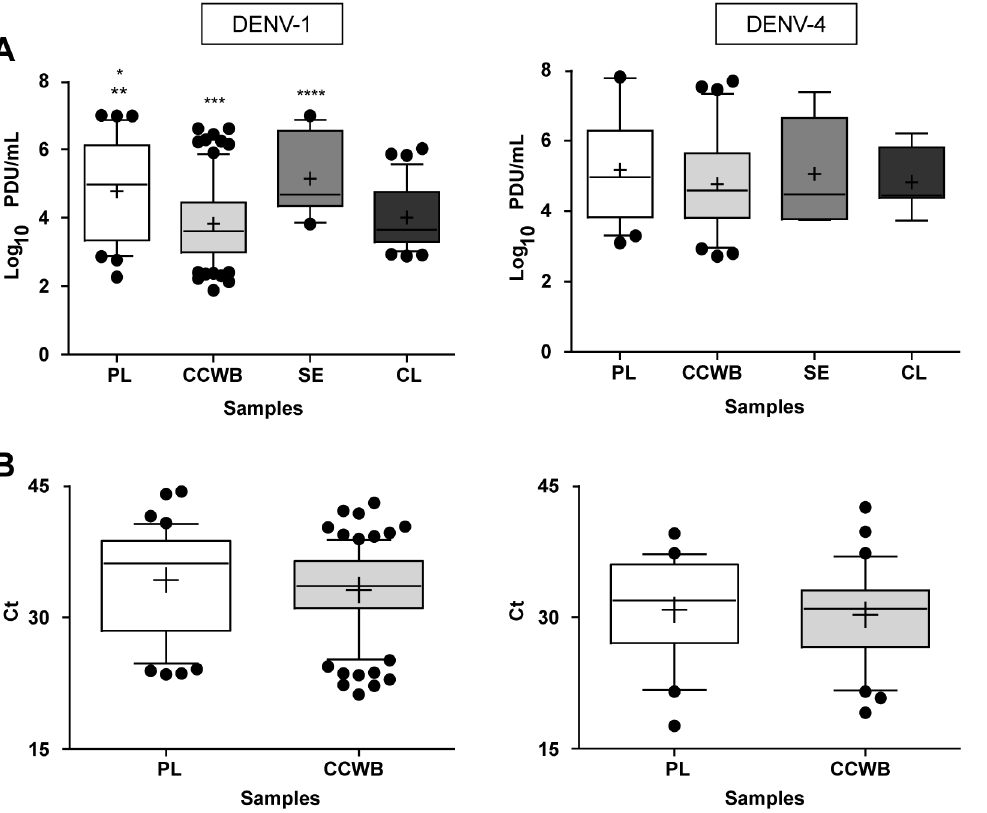
Fig 1. Detection of DENV RNA in blood components. A) DENV-1 and DENV-4 average viral load observed in plasma (PL), the cellular component of whole blood (CCWB), serum (SE) and homogenized clot specimens (CL). DENV viral load average in each sample co-component is expressed in log 10 PDU/mL. B) Ct value averages for DENV-1 and DENV-4 plasma (PL) and cellular component of whole blood (CCWB). Samples were collected from infected Puerto Rican blood donors, 2012 – 2013. Only samples with Ct values (cid:3) 38 were included in the quantitative analysis. Whiskers represent 10-90 th percentile. Outliers are shown as black dots. Mean is shown as a “ + ” sign and median as a horizontal line inside the box. Statistical significance is indicated as follows: * p < 0.001 vs CCWB; ** p < 0.05 vs CL; *** p < 0.001vs SE; **** p < 0.05 vs CL.